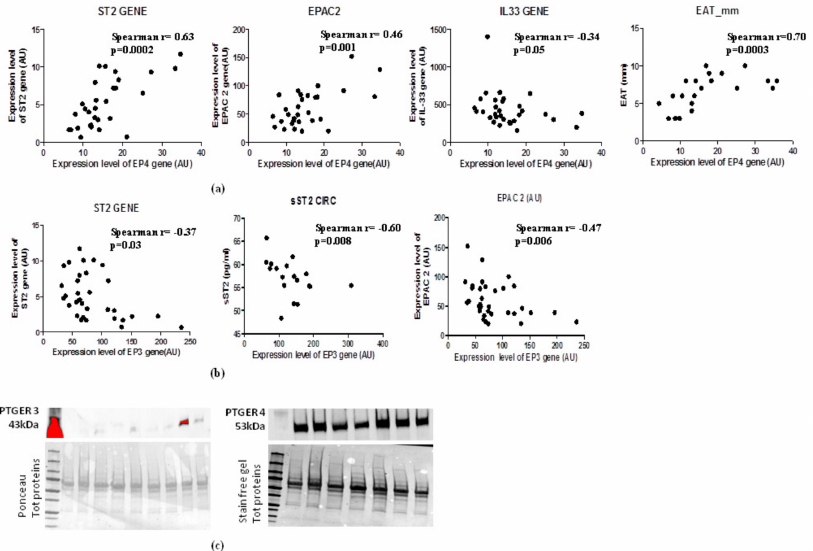
Figure 4. EAT mass increase deregulates EP3 and EP4 molecular expression levels with direct induction of ST2 gene via the EPAC2 cAMP e ff ector. ( a ) EP4 lipolytic PGE 2 receptor directly correlates with genes associated with mechano-tissue responses including EPAC2 cAMP e ff ector (Spearman r = 0.46, p = 0.001) and ST2 gene (Spearman r = 0.63, p = 0.002) and inversely with IL-33 molecular